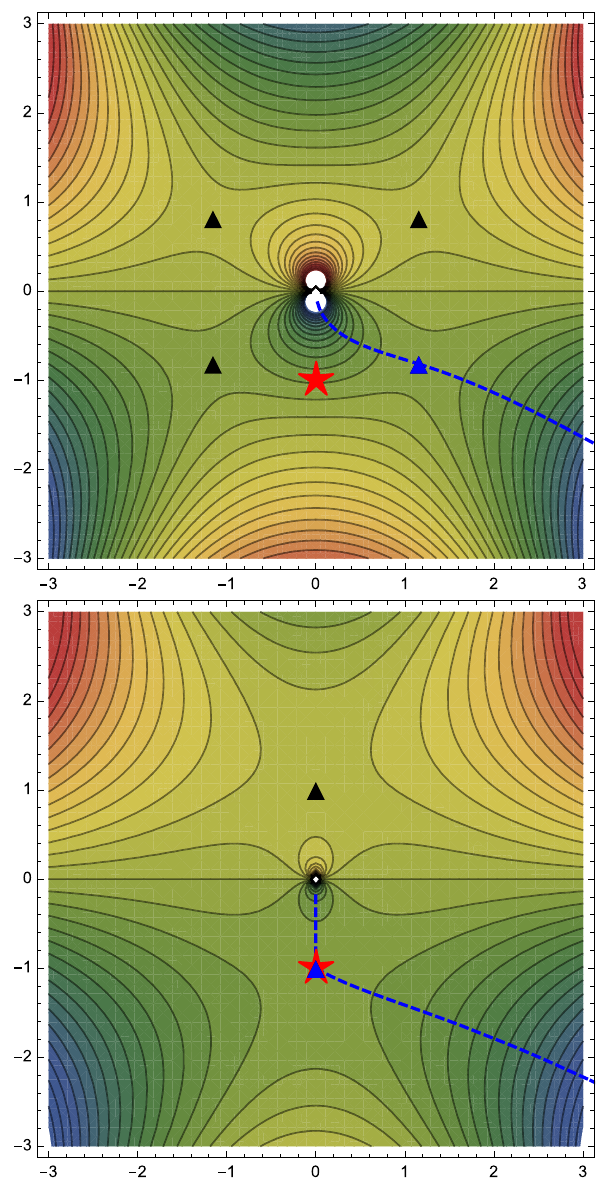
(cid:18) (cid:19) ( N ) iS saddle in complex plane where 0